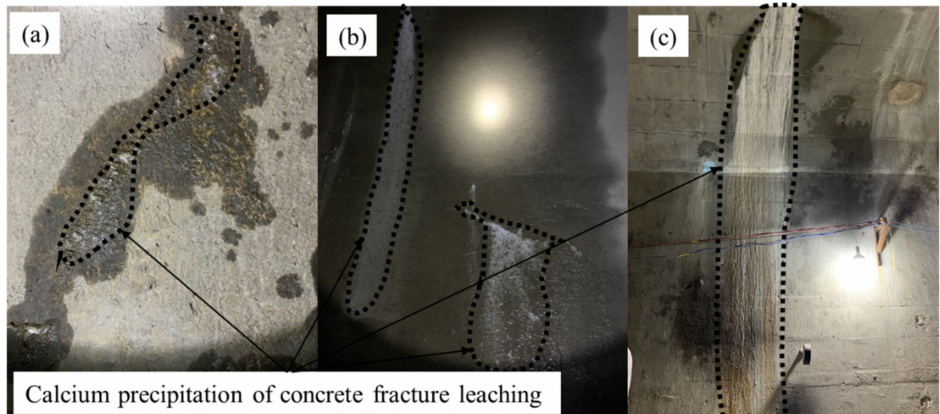
Figure 1. Different leaching degrees of hydration products from fractured regions in concrete (tunnel lining). ( a ) mild, ( b ) moderate and ( c ) severe.